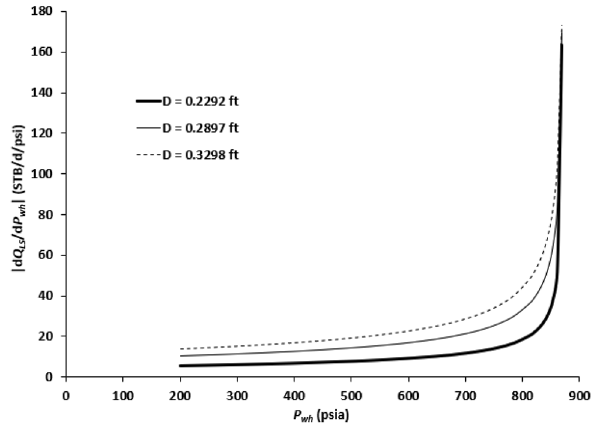
Fig. 14 Stability plots for well A at 30% water cut and P but different tubing sizes